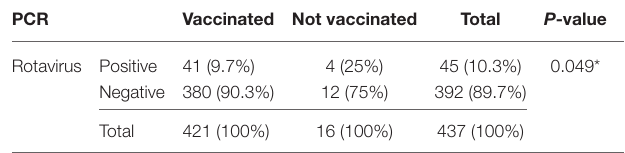
TABLE 2 | Frequency of samples with mixed viral, mixed bacterial, and viral bacterial infections. Pathogen